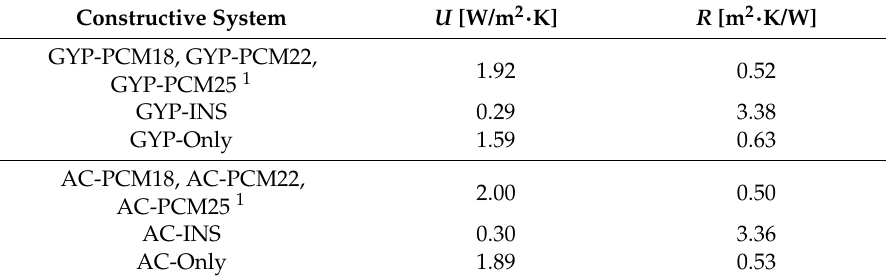
Table 6. Conductance values ( U ) and thermal resistance values ( R ) of all case scenarios. Constructive